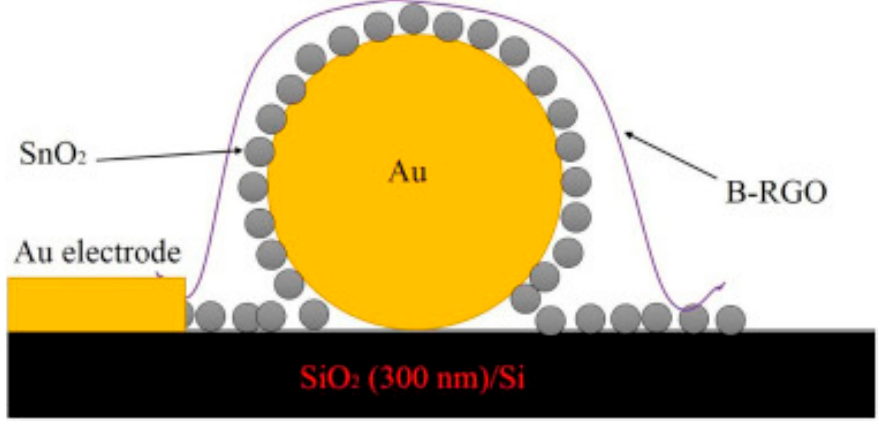
Figure 11. The schematic diagram of the B-RGO/SnO 2 @Au heterostructure-based sensor [93].